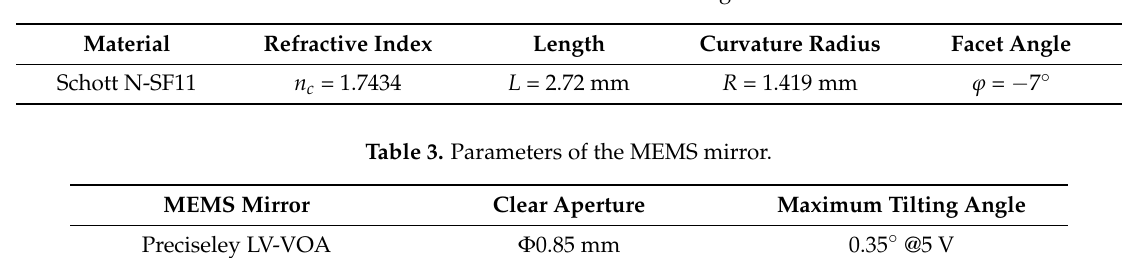
Table 2. Parameters of the collimating lens.